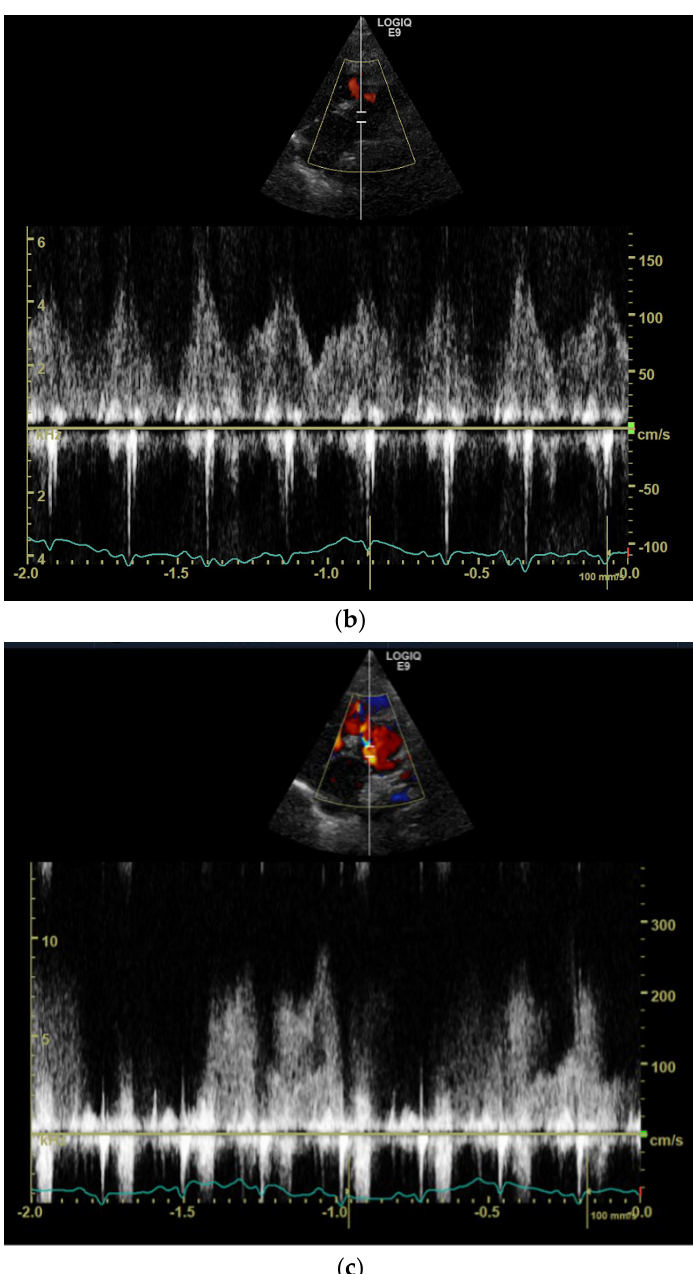
Figure 5. ( a – c ) Transthoracic left apical window modified 4–chamber optimized for showing the dilated PV (red *) emptying into the LA through a narrow ostium at the PV-LA junction. The anatomy and clinical condition of the cat did not allow for standard windows and views. ( a ) Color Doppler examination showing a turbulent blood flow between the dilated PV (red arrow) and the LA.; ( b ) Spectral Doppler examination performed with pulsed wave gate placed at what was believed to be the PV inlet. This view shows a continuous flow in at least one cycle. The angle is suboptimal, and therefore velocity is underestimated in the image.; ( c ) Spectral Doppler examination performed with pulsed wave gate placed at what was believed to be the PV inlet. The image shows a peak blood flow velocity of 2.6 m/s representing an estimated pressure gradient of 27 mmHg between the dilated PV and the LA and, therefore, an estimated PV pressure of at least 32 mmHg. The angle is suboptimal, and therefore continuous flow could not be shown. LA: left atrium, PV: pulmonary vein.